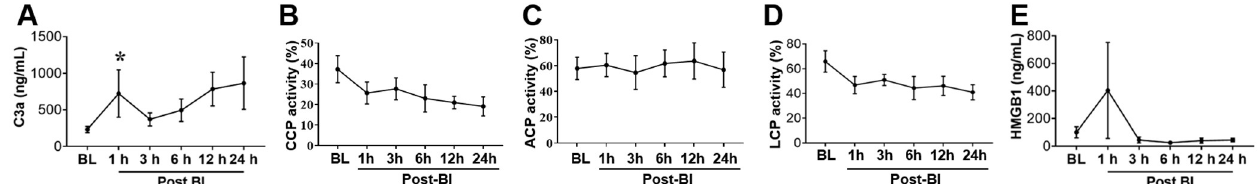
Figure 2. Systemic complement activation ( A – D ) and HMGB1 ( E ) in a porcine BI+HS model. CCP, classical complement pathway; ACP, alternative complement pathway; LCP, lectin complement pathway. The data are presented as mean ± SD (n = 5). * p < 0.05 vs. BL.